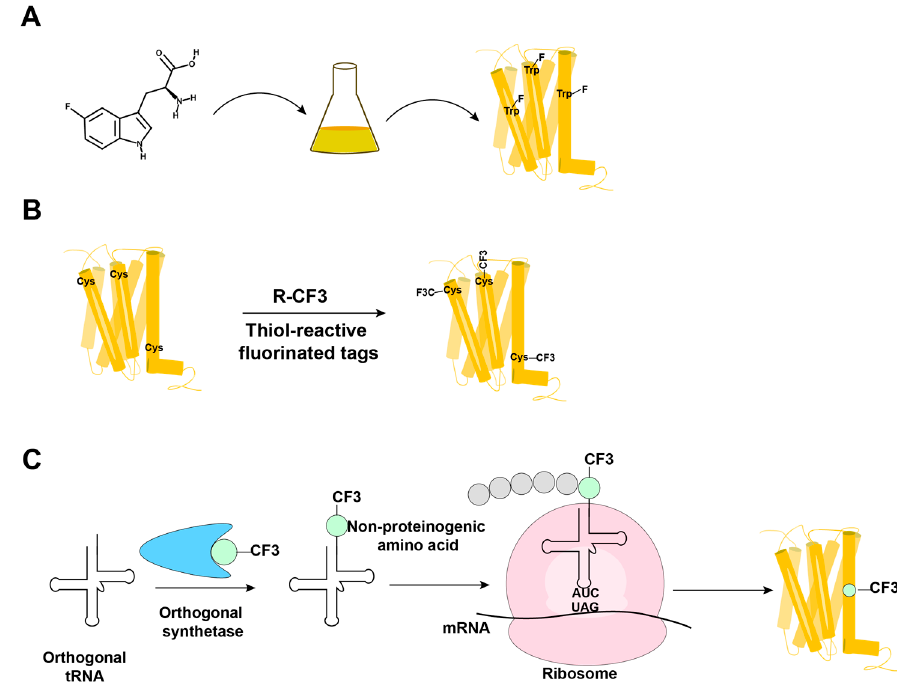
Figure 3. Overview of the methods in use for incorporation of 19 F-NMR labels into GPCRs. ( A ) Biosynthetic incorporation by adding fluorinated amino acids, such as 5F-Trp, to the expression system; all Trp residues in the protein are then labeled with 19 F. ( B ) Post-translational chemical modification by reacting the GPCR with thiol-reactive fluorinated tags; all reagent-accessible Cys residues are then labeled with the fluorinated tag. ( C ) Genetic labeling using an extrinsic orthogonal tRNA/aminoacyl-tRNA synthetase pair to incorporate non-proteinogenic 19 F-labeled amino acids at positions defined by a TAG amber codon.